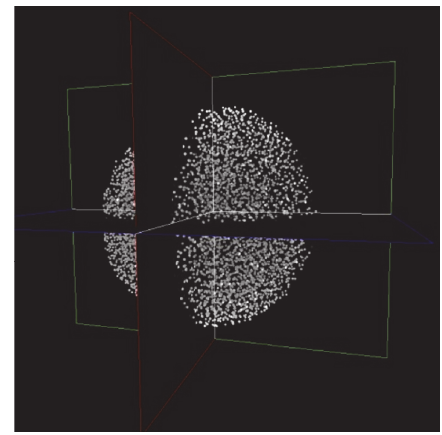
Figure 7: 3D visualization of TRISO particles in a pebble.